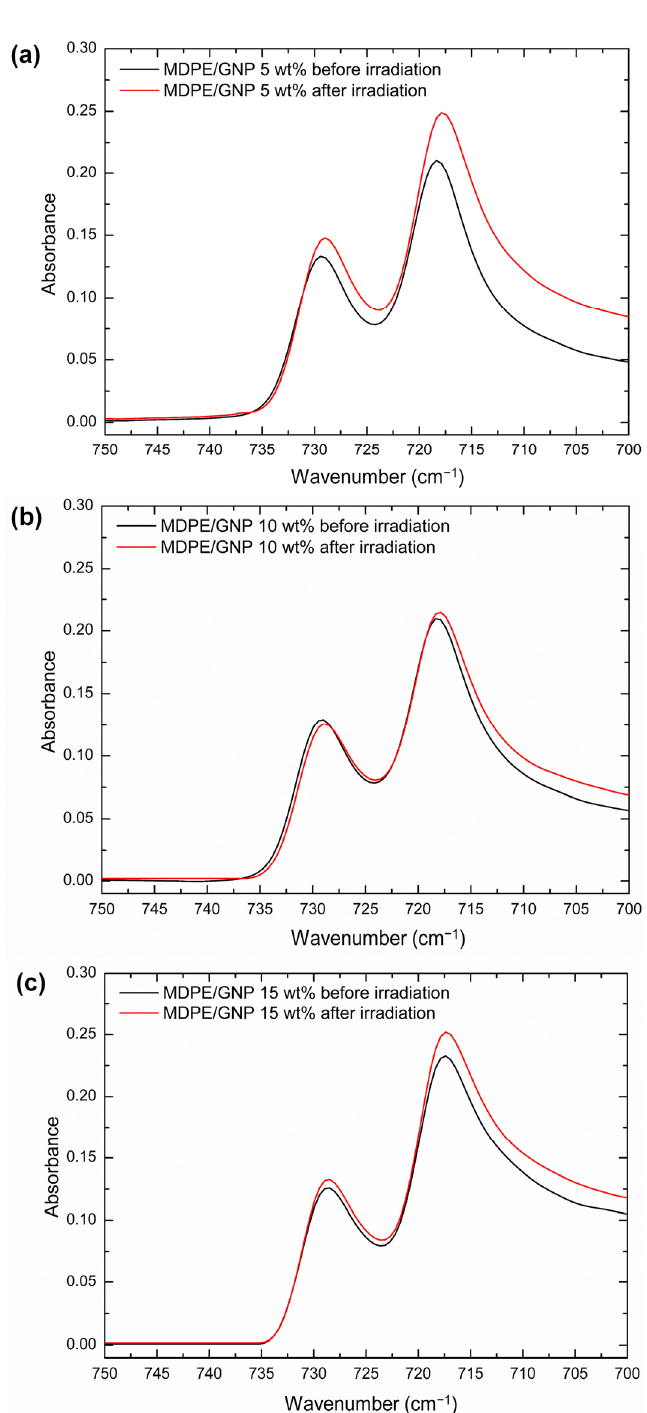
Figure 3. ATR-FTIR spectra of ( a ) MDPE/GNP 5 wt%, ( b ) MDPE/GNP 10 wt%, ( c ) MDPE/GNP 15 wt% nanocomposites before and after proton irradiation in the 750–700 cm − 1